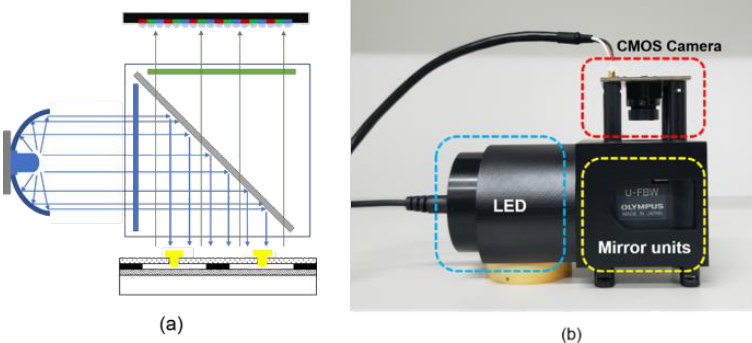
Figure 7. Fluorescence detection system. ( a ) Schematic diagram of the detection optical path. ( b ) Photograph of the 3D-printed structure with the integrated components.